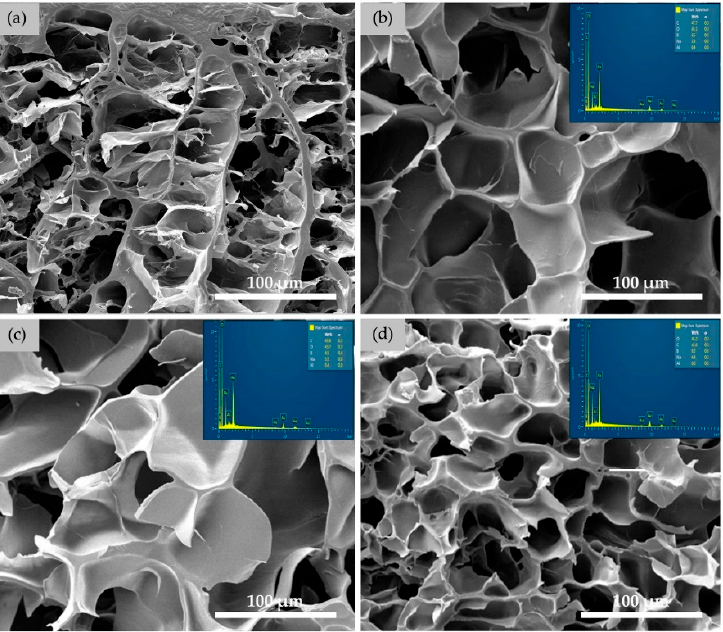
Figure 8. SEM micrographs and EDS spectra of DN starch hydrogels prepared with various borax